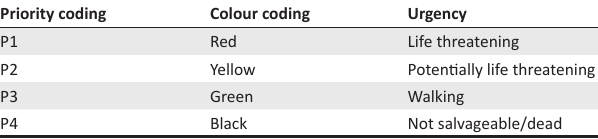
TABLE 1: Triage coding. Priority